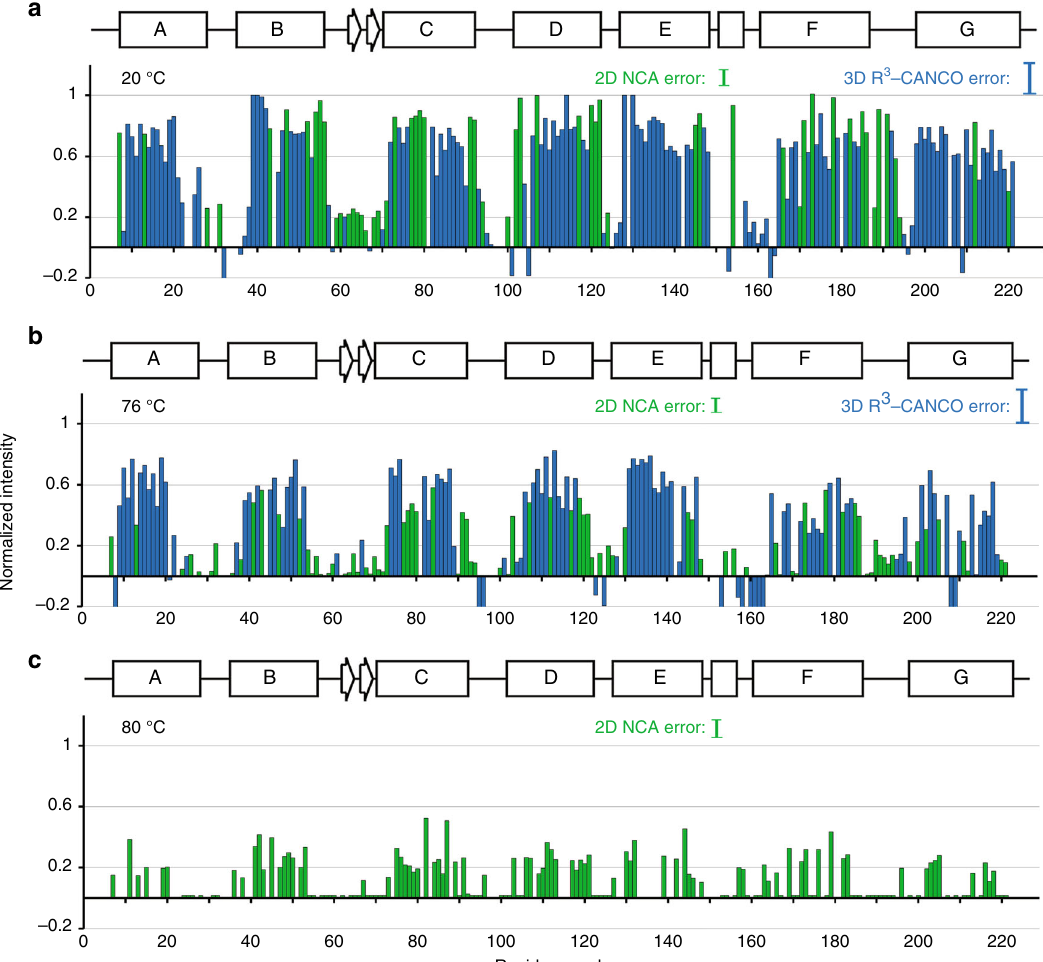
Fig. 5 Temperature dependent progression of the H/D exchange. Normalized cross-peak intensities were obtained from the 3D R 3 -CANCO (blue) and 2D NCA (green) spectra collected after incubation in D 2 O based buffer at 20°C ( a ), 76°C ( b ), and 80 °C ( c ). All data were extracted from spectra collected